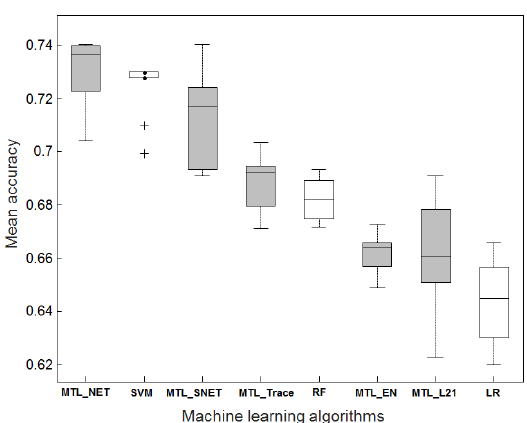
Figure 1. Predictive performance comparison between eight algorithms. The ‘leave-dataset-out’ procedure was used for comparison. Four out of five datasets were combined for training, and then the model was tested on the remaining dataset. The distribution of accuracy estimates indicated the variation of parameter selection across 10 repetitions. The boxplots in gray denote the multi-task learning algorithms.